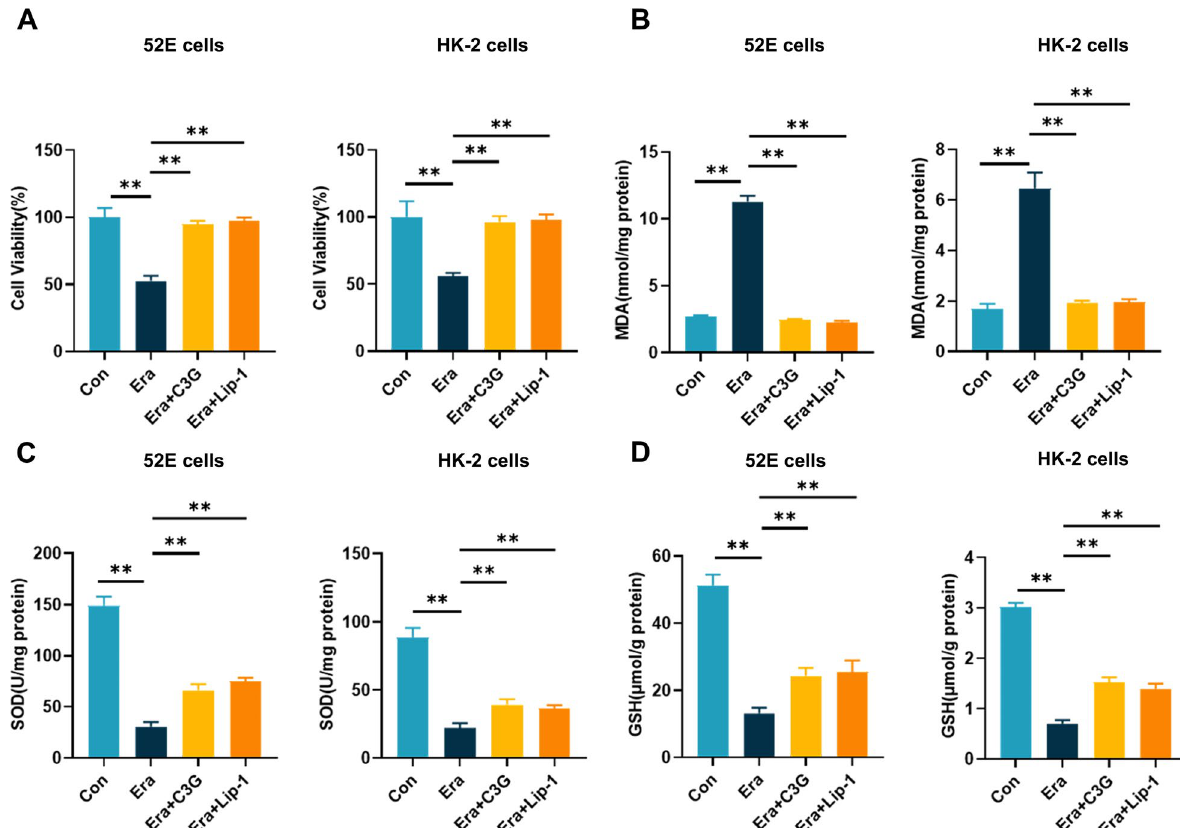
Fig. 1 C3G markedly ameliorated ferroptosis in 52E cells and HK‑2 cells. A Cell viability determined by CCK‑8 cell viability assay. (n were treated with drugs for 24 h; B – D The levels of MDA, SOD and GSH of different groups in 52E cells and HK‑2 cells respectively. (n were treated for 24 h. *p < 0.05, **p < 0.001. C3G cyanidin‑3‑glucoside, CCK-8 cell counting kit‑8; MDA malondialdehyde, SOD superoxide dismutase; GSH glutathione, HK-2 human proximal tubule epithelial